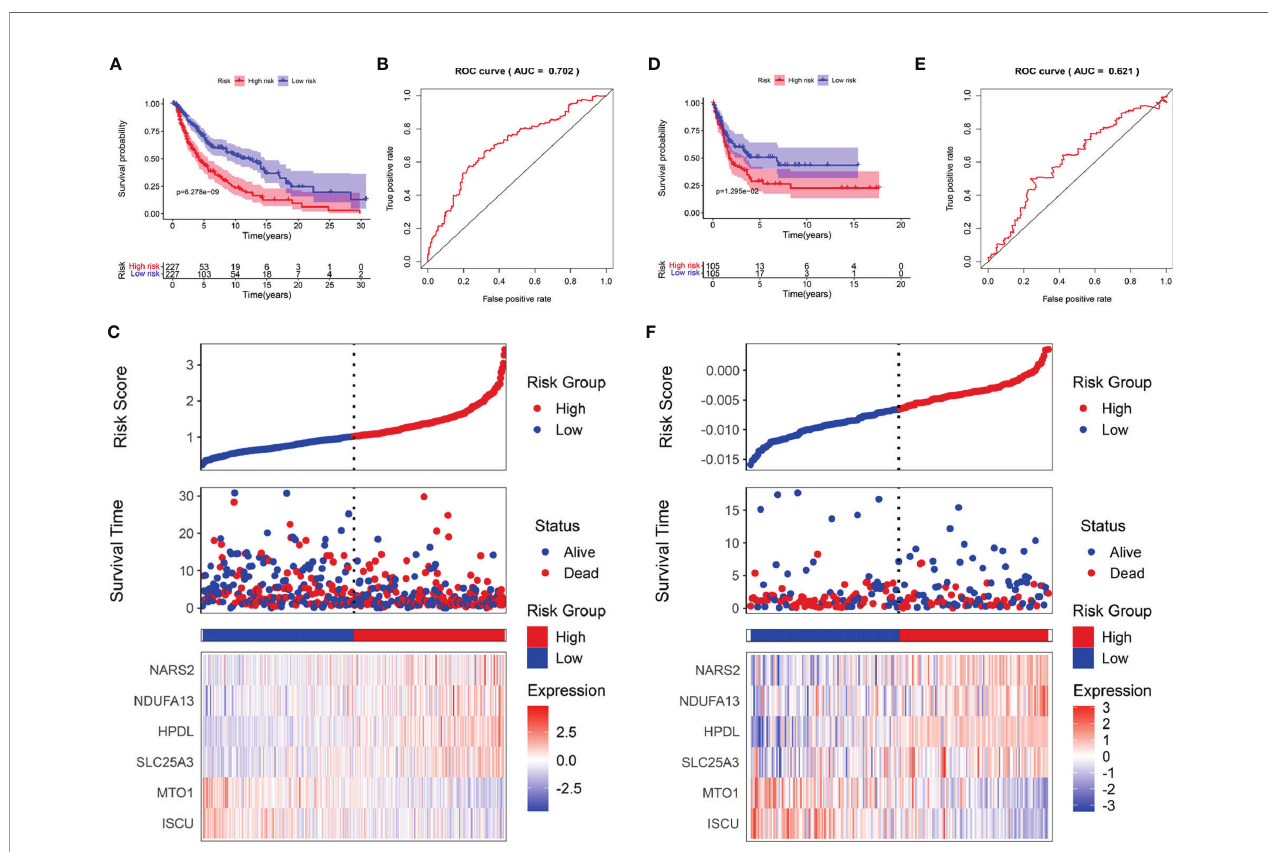
FIGURE 5 | The prognostic value of the LRG signature for SKCM patients. The survival analysis in TCGA cohort (A) and GSE54467 cohort (D) . ROC curves indicated the predictive ef fi ciency of the prognostic signature in TCGA cohort (B) and GSE54467 cohort (E) . The risk score distribution, survival status, and heatmap for the expressions of the six genes in TCGA cohort (C) and GSE54467 cohort (F)